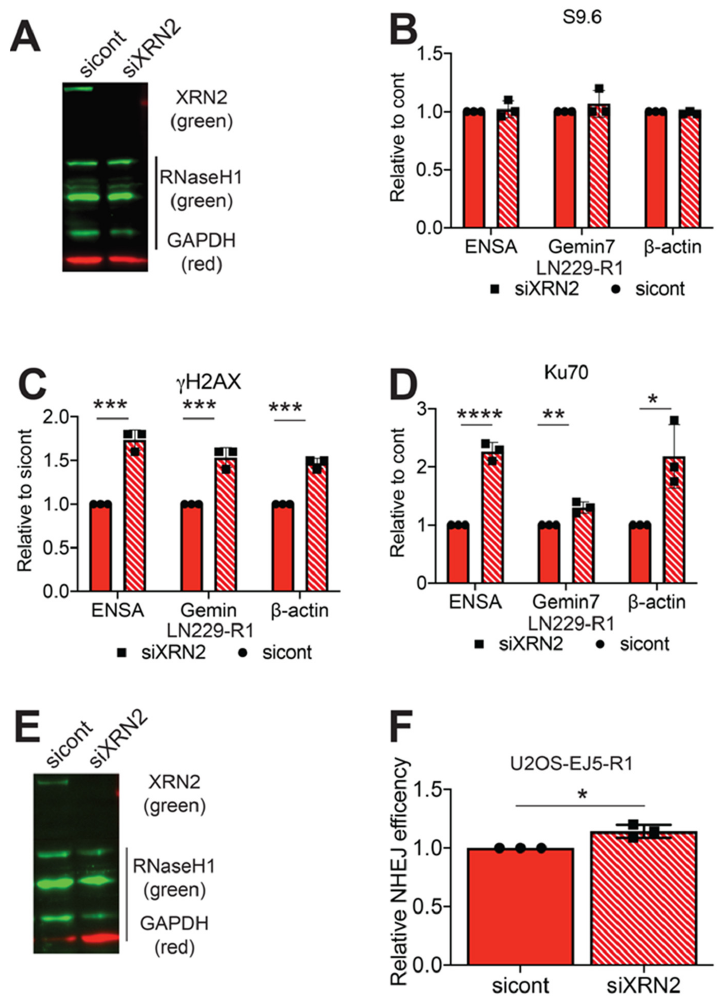
Figure 4. RNaseH1 expression restores NHEJ repair in XRN2 deficient cells. ( A ) Steady-state protein levels of XRN2 was measured in LN229-R1 cells exposed to control or XRN2 siRNAs. Chromatin immunoprecipitation / qPCR experiments were performed using ( B ) S9.6, ( C ) γ H2AX and ( D ) Ku70 antibodies at the 3’ end of the ENSA , Gemin7 and β -actin genes in LN229-R1 cells exposed to control and XRN2 siRNAs. ( E ) Steady state protein levels of XRN2 was determined in U2OS-EJ5-R1 cells exposed to control and XRN2 siRNAs. ( F ) E ffi ciency of NHEJ repair in the U2OS-EJ5-R1 reporter cells transfected with control or XRN2 siRNAs was determined by measuring 1000 cells for GPF expression and normalizing to control cells. Statistical analysis was done using Student’s t -test. * = p < 0.05, ** = p < 0.01 and **** = p < 0.00001. Detailed information about Western blot can be found at Figure